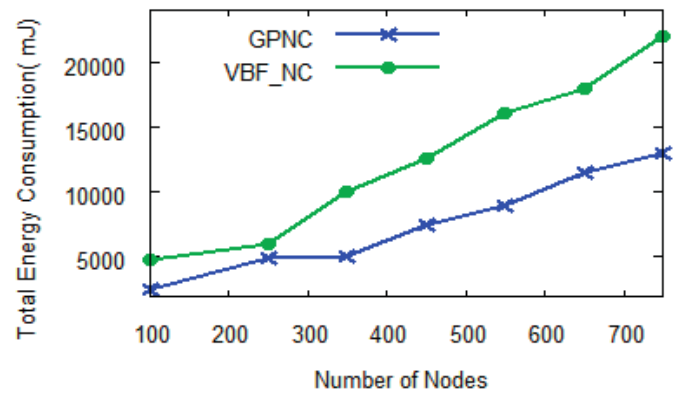
Figure 10. Energy consumption with the number of nodes when N = 5.